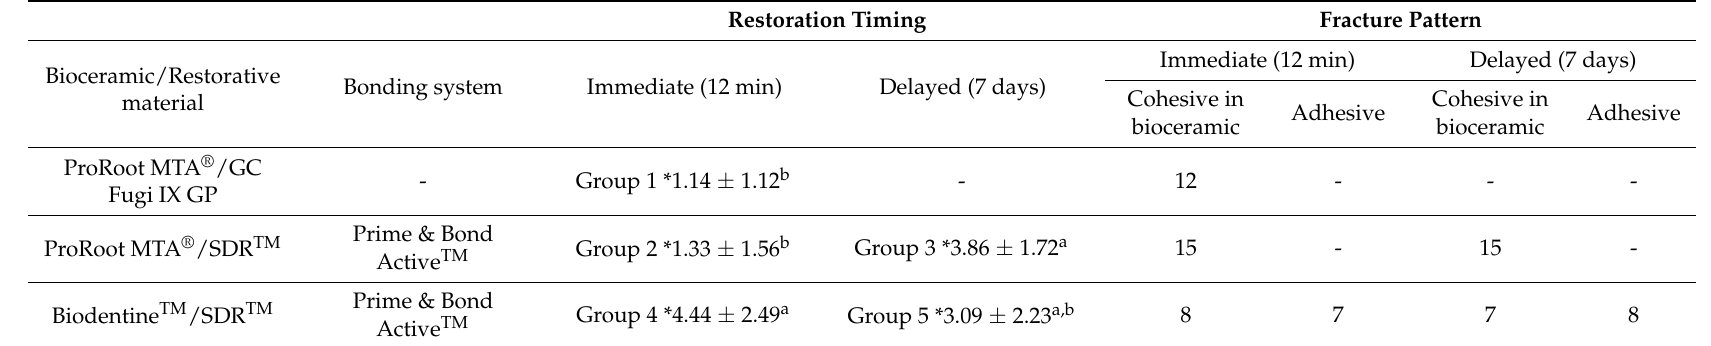
Table 1. Mean bond strength values and fracture pattern of the tested groups following shear bond strength